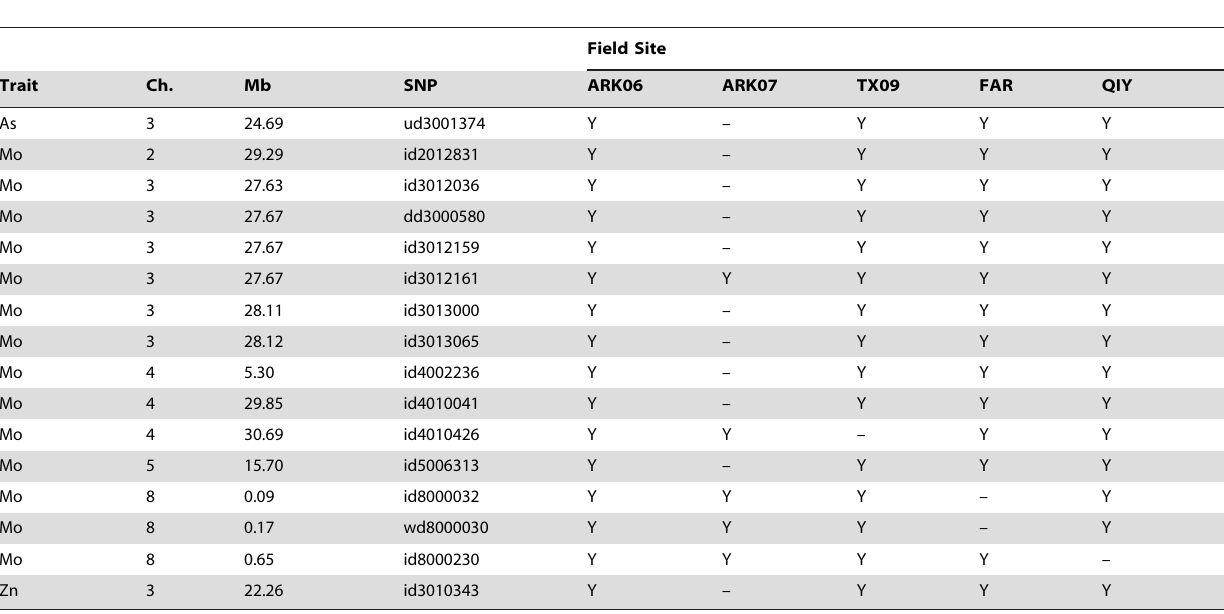
Table 4. SNPs identified in GWA studies as being in the top 1% most significant in at least four of the five field sites, with site identified with